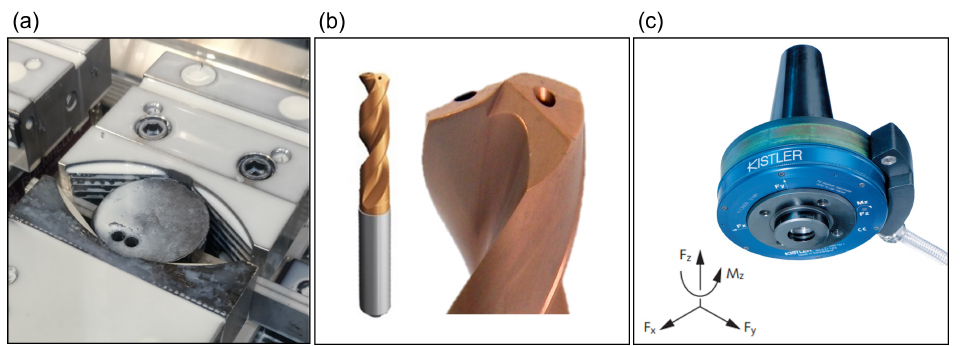
Figure 1. ( a ) Clamped Titanium FAST-DB Billet, ( b ) Coated Corodrill R846 Tool, ( c ) Kistler Dy- namometer